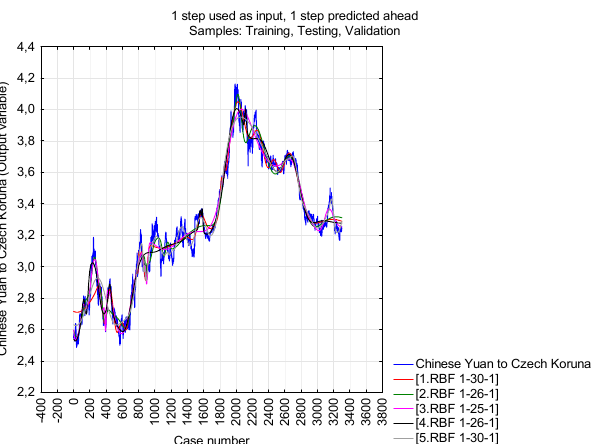
Figure 3. Actual and predicted (according to retained neural networks) development of CZK/RMB exchange rate during the monitored period (Source: Own research; according to Machova and Marecek 2019).